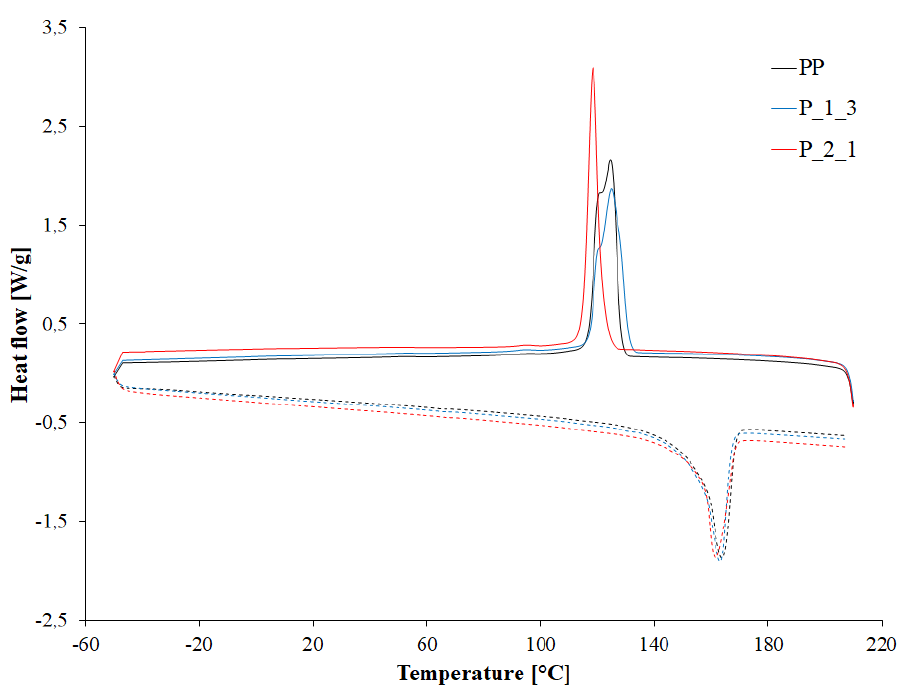
Figure 8. DSC curves of cooling (solid line) and heating (dashed line) of selected samples. The nature of the crystallization process also changed. At lower waste contents, the recorded peak of the crystallization process was much lower but wider than the peak recorded at the highest filler content. The enthalpy change of the crystallization process ( Δ H c ) was also higher. With the increase in the content of waste, the Δ H c value decreased by 14.3 J/g, from 95.1 J/g for the P_1_3 sample to 80.8 J/g for the P_2_1 sample. Thus, the waste content affects the structure and amount of the crystalline phase formed in PP. With a lower waste content, the formed crystallites are probably larger, and there are more of them. Changes in the crystallization process are influencing the structure and quantity of the crystalline phase and obviously translate into the recorded melting process and the calculated degree of crystallinity. As the filler content increases, the melting point (T m ) of the materials slightly decreases. The Tm decrease is approx. 2 °C when comparing the PP sample and the P_2_1 sample. The decrease in the melting enthalpy ( Δ H m ), and thus the degree of calculated crystallinity (X c ), was much more pronounced. The Δ H m value de- creased by 15.6 J/g comparing the PP and P_2_1 sample. Thus, the degree of crystallinity of the tested materials decreased from 47.7 to 36.2%. All results of DSC are presented in Table 3.